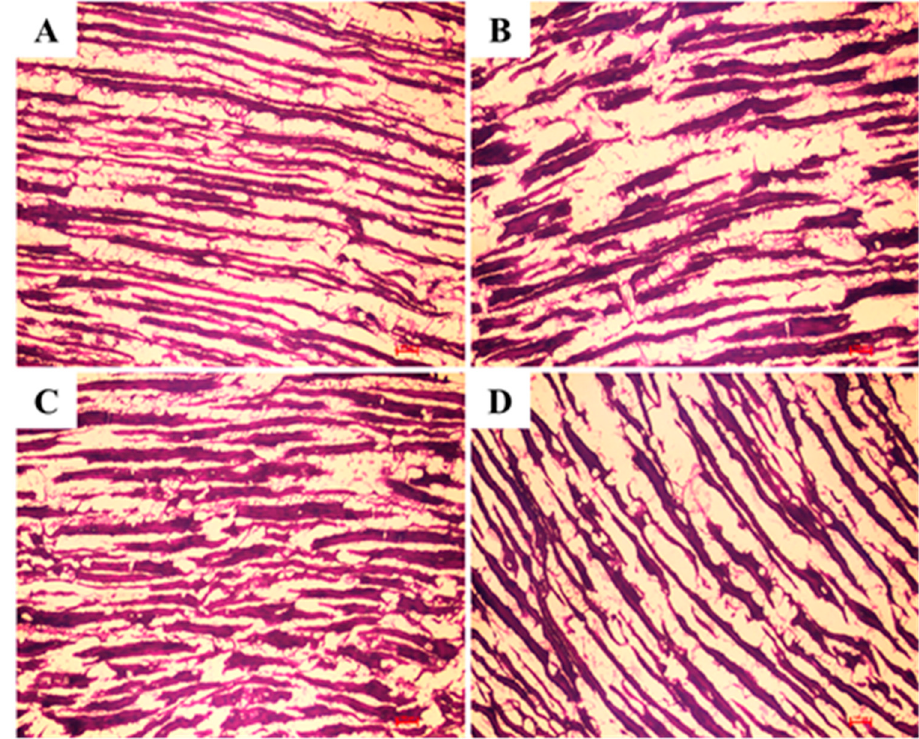
Figure 6. Muscle sections were prepared to form different groups of animals and subjected to phosphotungstic acid-hematoxylin (PTAH) staining. Normal Sprague Dawley (SD) rat ( A ); aged SD rat ( B ); aged SD rat treated with Testofen ® ( C ); aged SD rat with NZS extracts ( D ).